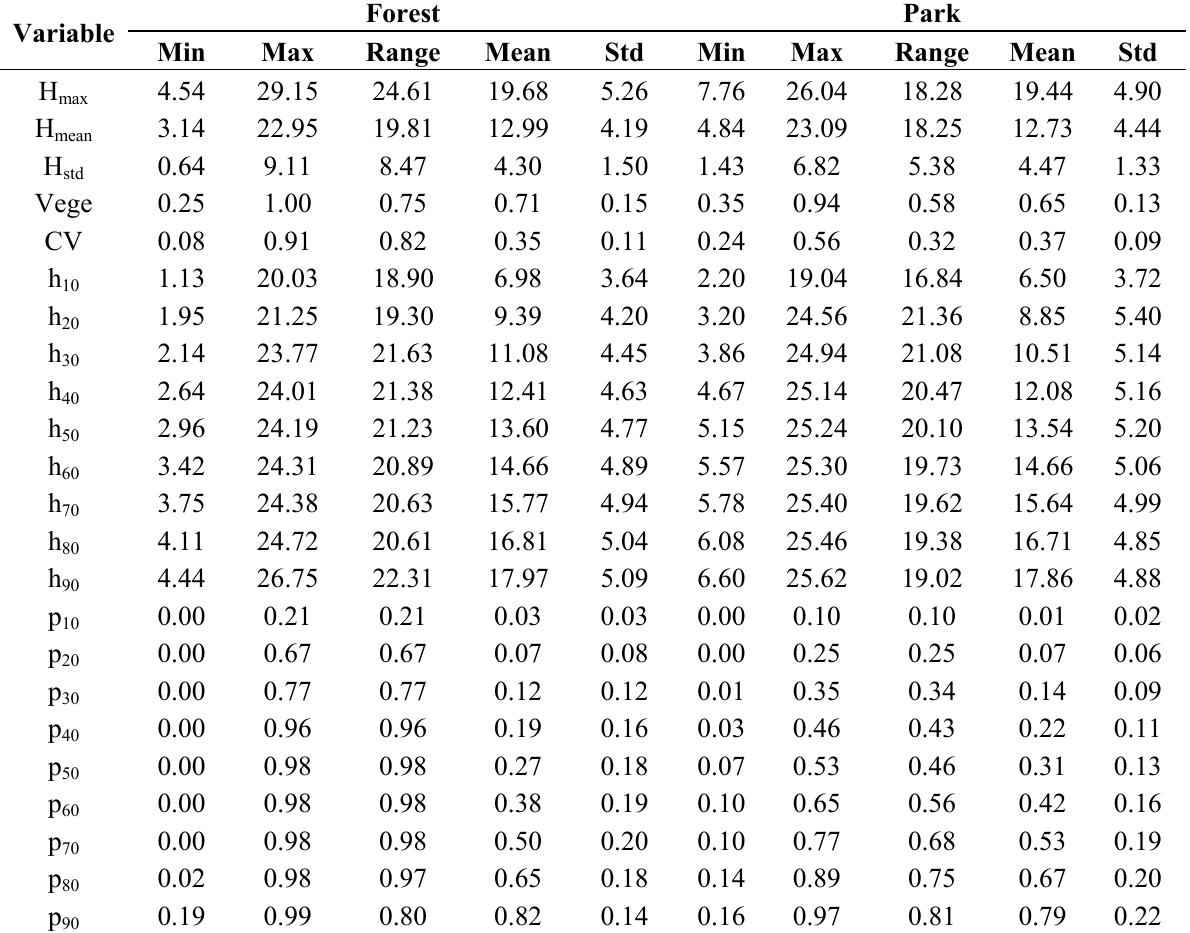
Table 3. Statistics, such as minimum (min), maximum (max), range, mean, and standard deviation (Std) calculated from the extracted predictor